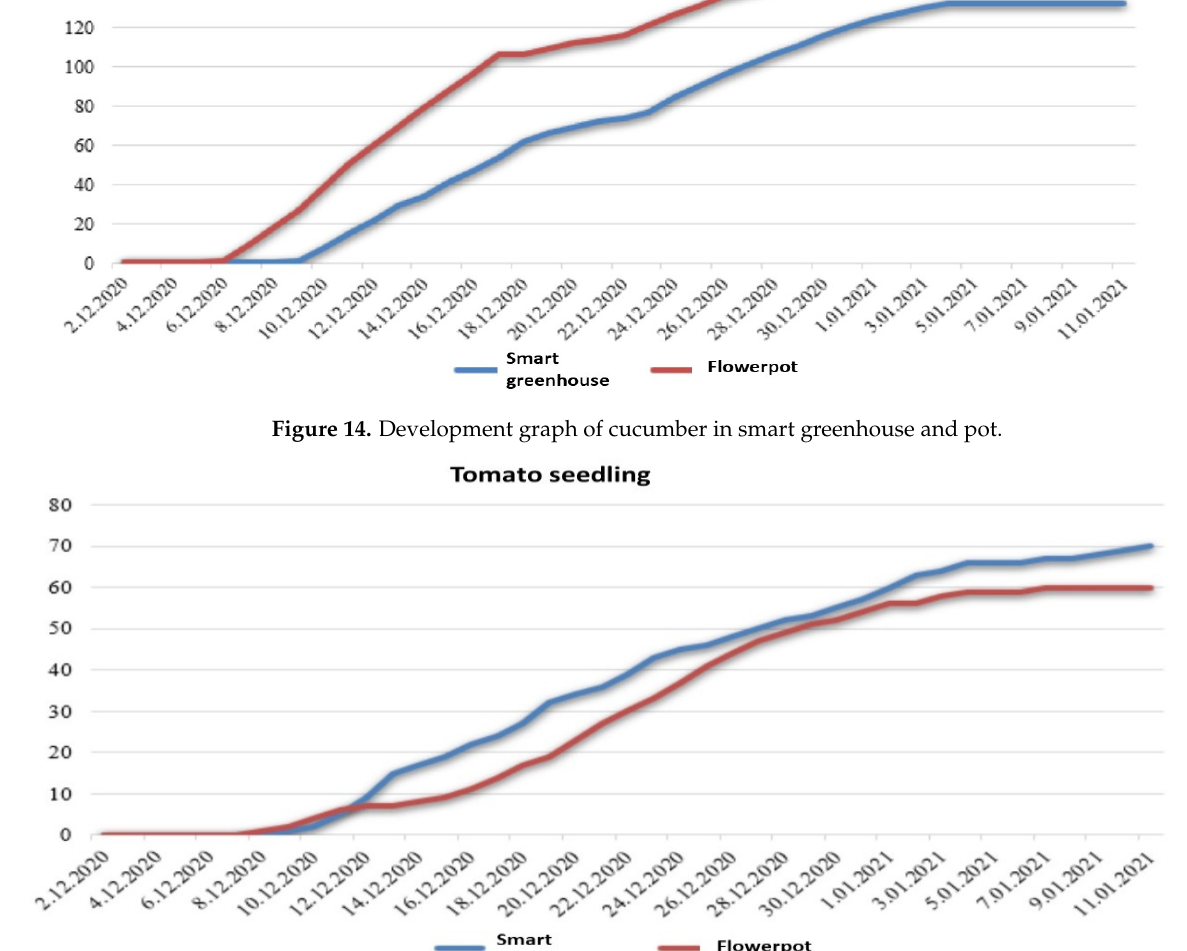
Figure 15. Development graph of tomato in smart greenhouse and pot.